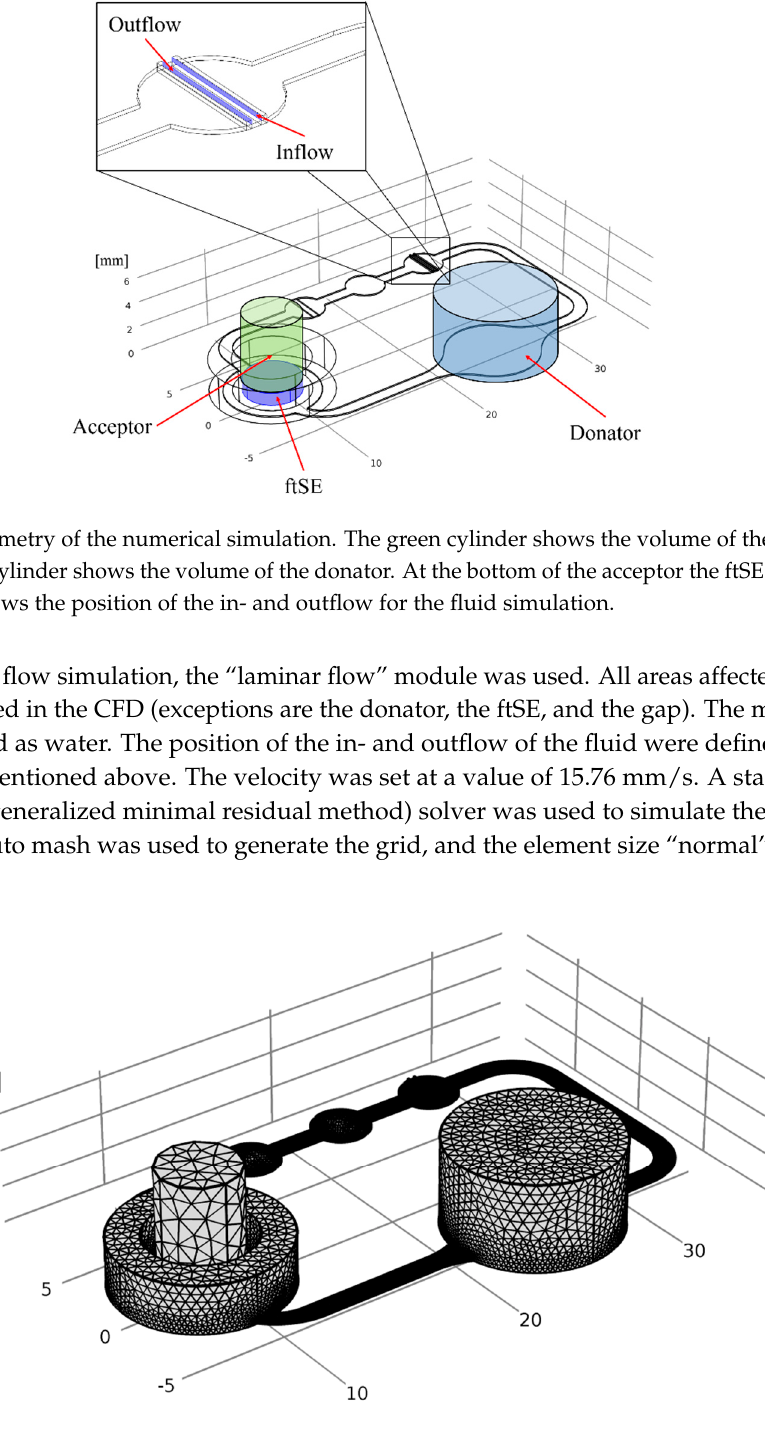
Figure 6. The mash of the numerical simulation. To generate the grit, the auto mash function with “normal” tetrahedral element size was used.